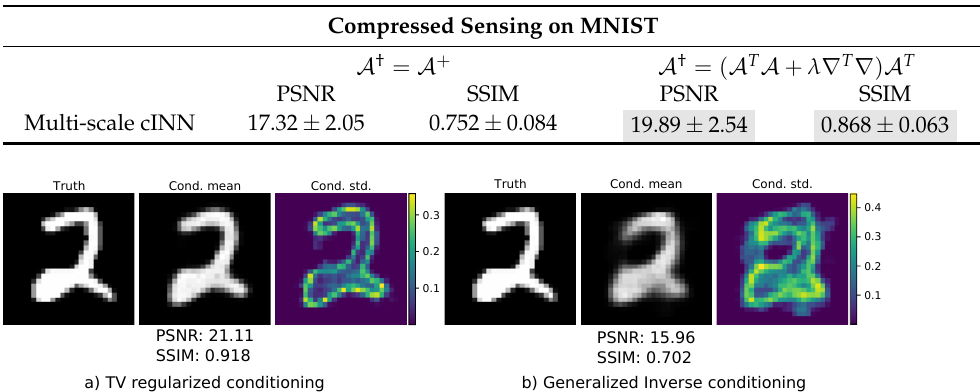
Table 1. Mean and standard deviation of the PSNR and SSIM for compressed sensing on the MNIST test dataset. The conditioned mean was computed with 100 samples.